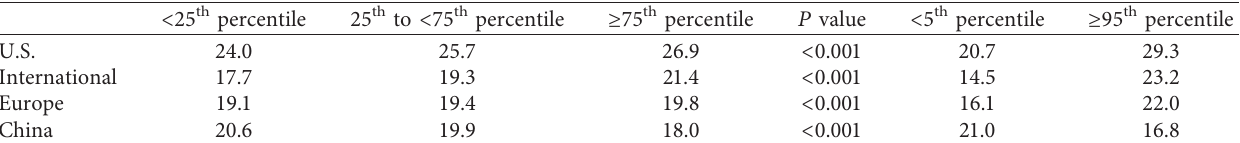
Table 3: Prevalence of high blood pressure (%) in the study population based on the 4 reference systems stratified by height. < 25 th percentile 25 th to < 75 th percentile ≥ 75 th percentile P value